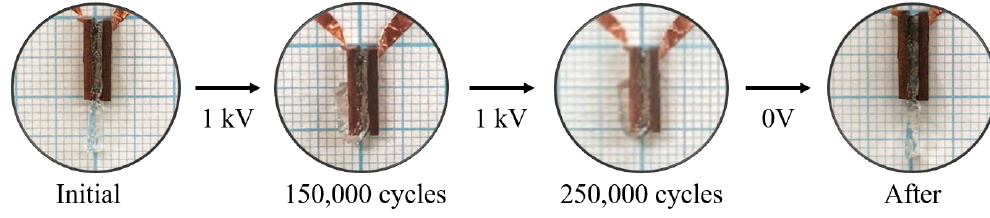
Figure 15. The result of the cycling performance for the PVC H 11 gel-based bending actuator.